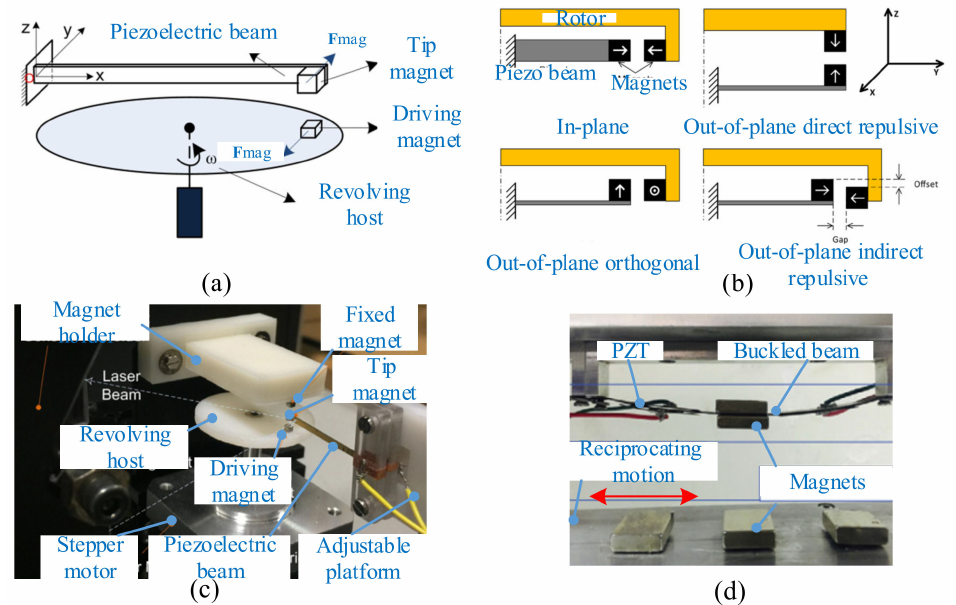
Figure 14. Magnetic plucking harvesters with a single piezoelectric beam. ( a ) The rotational energy harvester (reproduced with permission from [190]; published by Elsevier B.V., 2017). ( b ) Magnetic plucking configurations (reproduced with permission from [191]; published by Elsevier B.V., 2016). ( c ) A bistable frequency-upconverting harvester (reproduced with permission from [192]; published by Elsevier, 2018). ( d ) A multistep harvester (reproduced with permission from [193]; published by Elsevier,